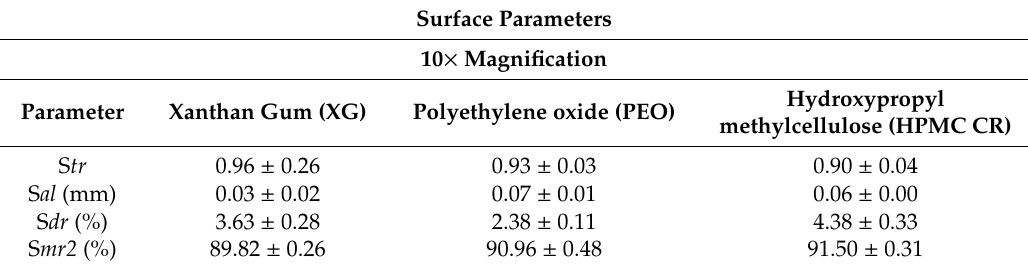
Figure 5. Optical images obtained from focus variation microscopy of the polymer compact surfaces at 10 × magnifications: ( a ) xanthan gum (XG), ( b ) polyethylene oxide (PEO), ( c ) hydroxypropyl methylcellulose (HPMC CR). 3D roughness maps obtained from the focus variation microscope for the polymer compact surfaces at 10 × magnifications: ( d ) xanthan gum (XG), ( e ) polyethylene oxide (PEO), ( f ) hydroxypropyl methylcellulose (HPMC CR). Table 2. Table displaying average surface parameter values at 10 × magnification for the three hydrophilic polymers.